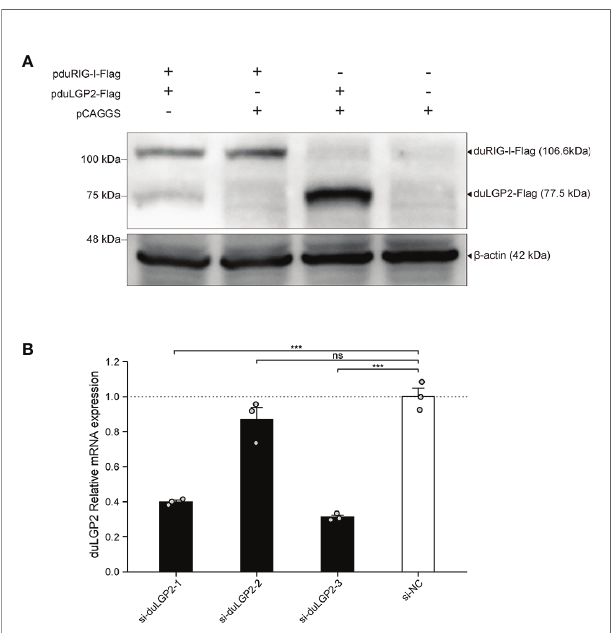
FIGURE 1 | Expression of pduLGP2-Flag and pduRIG-I-Flag, and Knockdown of duLGP2 by siRNAs in DEF cells. (A) DEF cells were transiently transfected with the expression plasmids or empty plasmids pCAGGS. Western blot was performed at 36 hpt. (B) DEF cells were transiently transfected with siRNAs. The duLGP2 relatively mRNA expression was detected at 36 hpt using qRT-PCR. All samples were analyzed in triplicate, and all data were expressed as means ± SEM. ***Extremely signi fi cant ( P < 0.001); ns, no signi fi cant